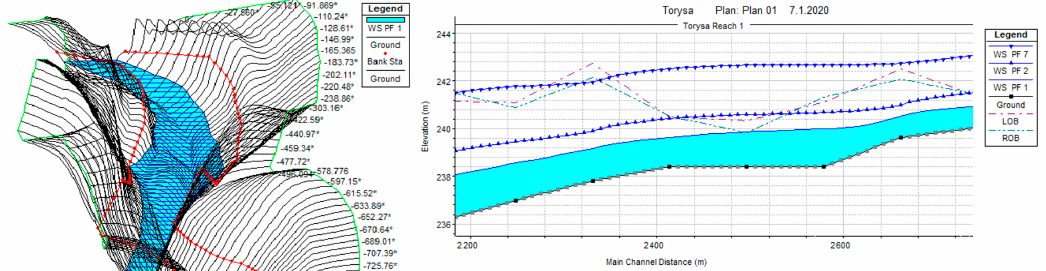
Figure 9. 3D schematization of cross ‐ sections and profile plot in HEC–RAS interface.